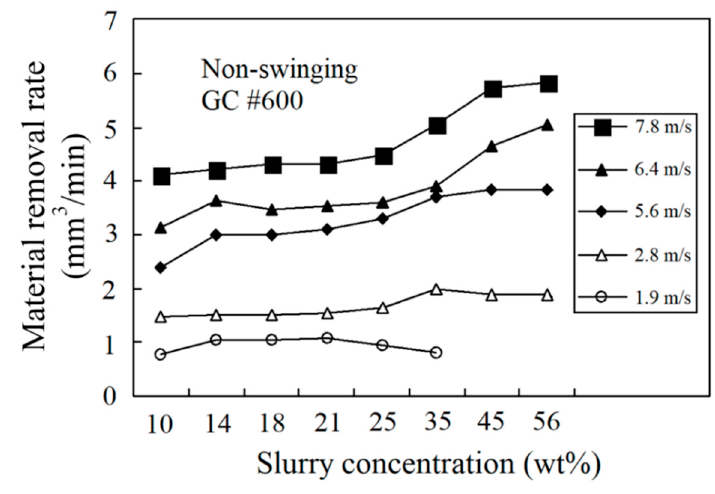
Figure 3. Effect of different wire speeds and slurry concentrations on material removal rate (MRR).